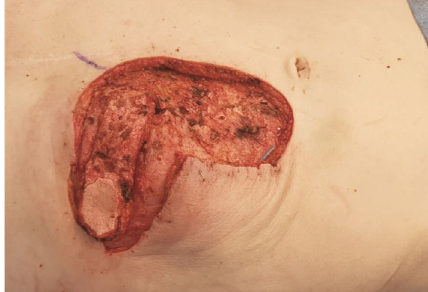
Figure 6: The fl ap was rotated by 90 ° and about 70% of the skin surface of the fl ap was deepithelialized to allow fi lling of the cavity as a “ buried fl ap. ” The remaining 30% served as a skin island for postoperative fl ap monitoring.